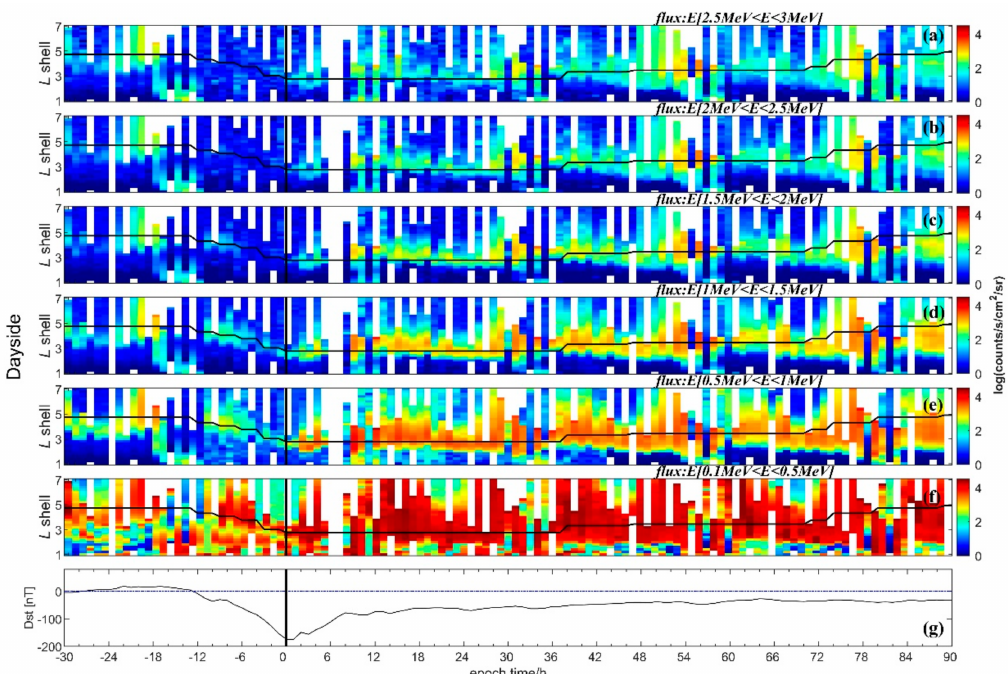
Figure 6. The dayside temporal and spatial evolution of energetic electron fluxes at energies from 0.1 to 3 MeV detected by high energetic particle package (HEPP)-L on board the CSES during the storm that occurred on 26 August 2018. From top to bottom: ( a ) 2.5–3 MeV, ( b ) 2–2.5 MeV, ( c ) 1.5–2.0 MeV, ( d ) 1.0–1.5 MeV, ( e ) 0.5–1 MeV, and ( f ) 0.1–0.5 MeV; ( g ) the Dst index. The overlapping black curves denote the location of the plasmapause estimated from Dst values. The vertical dashed line marks the time of the Dst minimum.